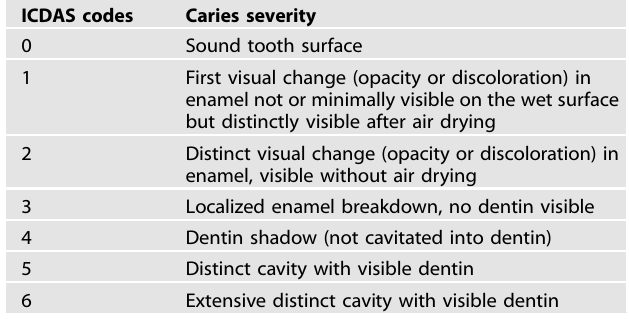
Table 1. International Caries Detection and Assessment System (ICDAS) scoring criteria